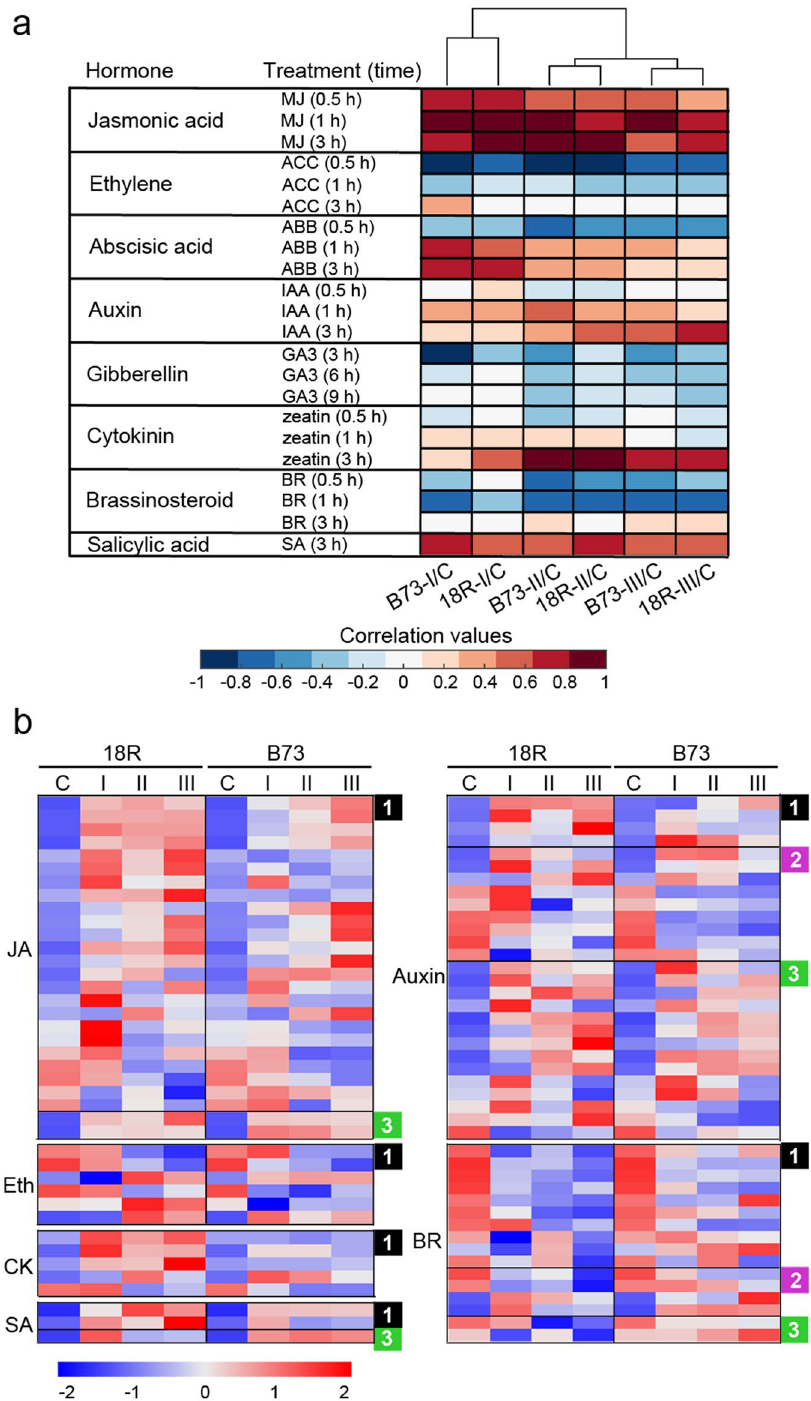
Figure 4. Hormone-regulated protein analysis based on the proteomic data. ( a ) The hormone response genes analyzed by Hormonometer program 18 based on the Arabidopsis homolog. Red color represents a positive correlation between the maize protein response to induction medium and to different hormones, while blue color represents a negative correlation. ( b ) Relative expression patterns of hormone-related proteins. Each hormone-related proteins are divided into three functional categories 19 : 1, synthesis-degradation; 2, signal transduction; and 3, induced- or regulated- or responsive-